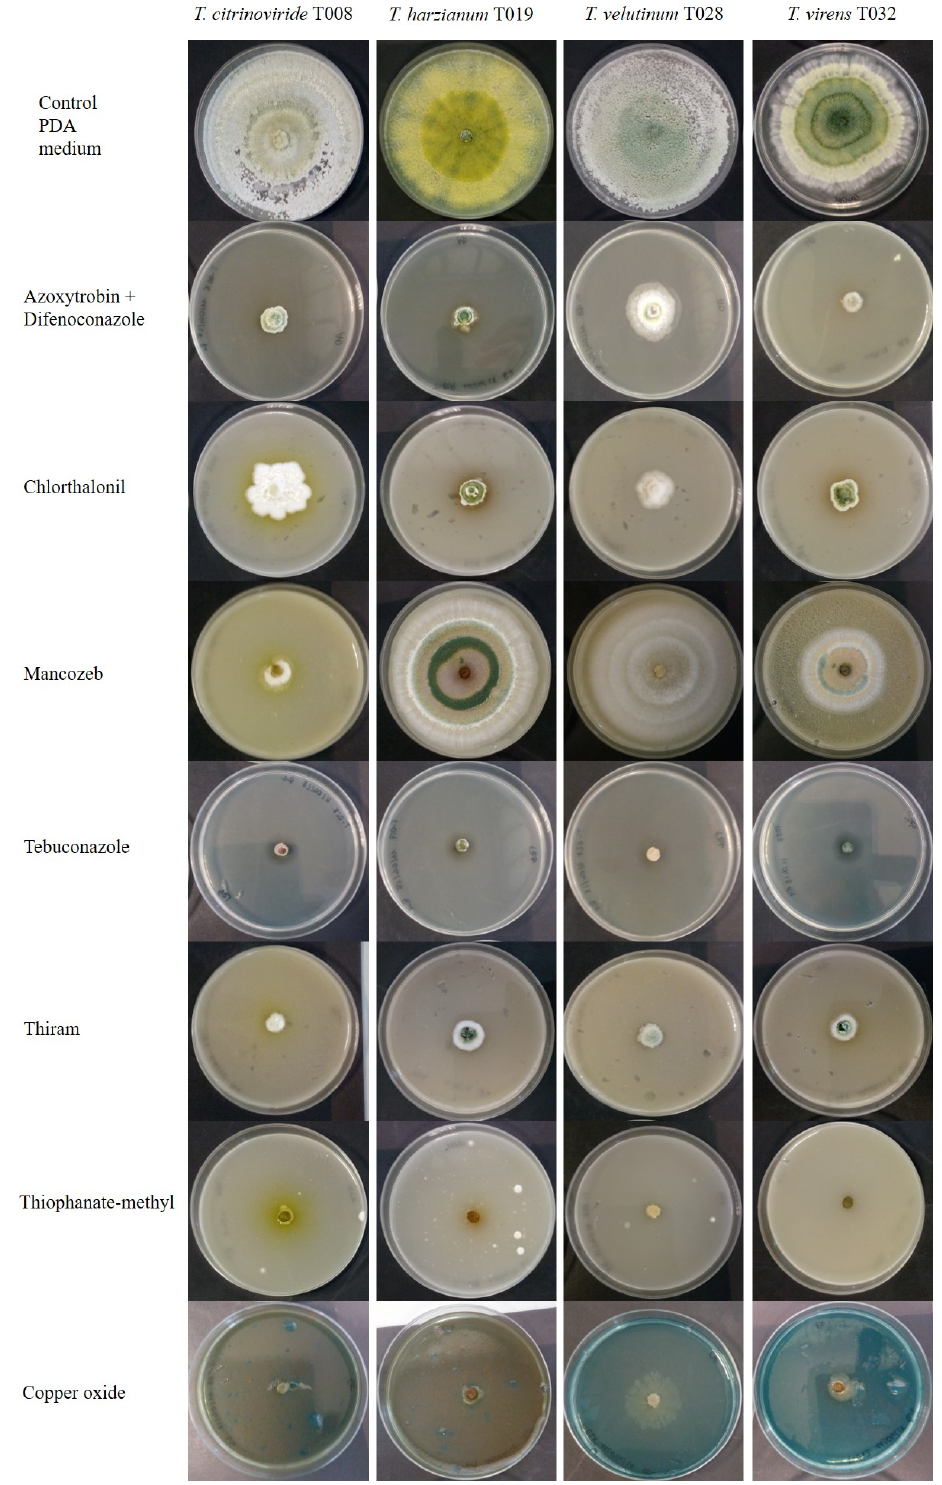
Figure 7. Growth of autochthonous Trichoderma strains in medium with synthetic fungicides at day 5 after inoculation.